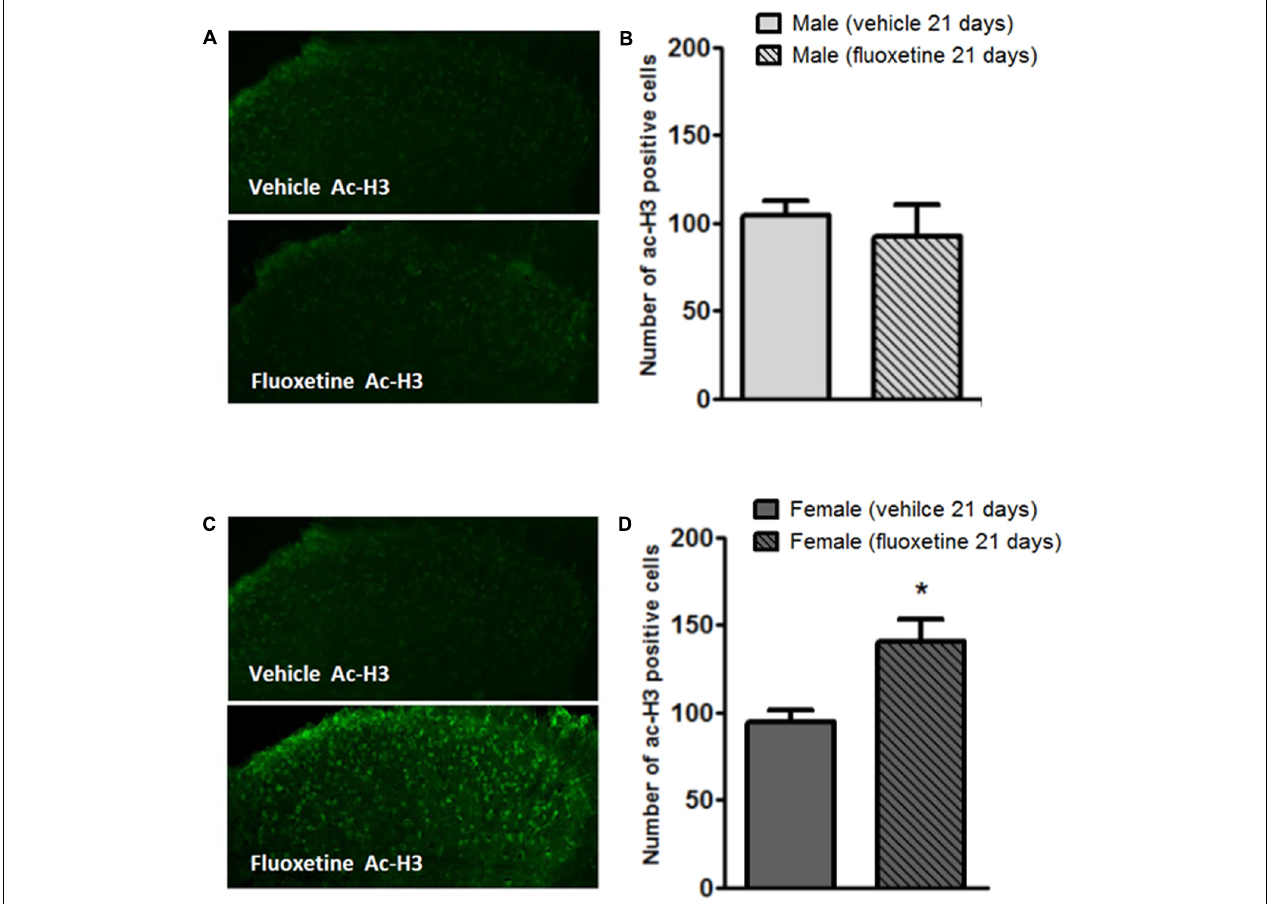
FIGURE 4 | Modulation of acetyl-H3 positive cell density in the dorsal horn of male and female mice by chronic treatment with fluoxetine. (A,C) Representative examples of acetyl-H3 immunopositive cells in the mouse dorsal horn from male and female mice treated with vehicle or fluoxetine (10 mg/kg, i.p.) for 21 days. (B,D) Quantification of immunopositive cells. Bars represent average ± SEM of three animals. ∗ p < 0.01 (Student’s t -test) versus values obtained in animals of the same sex treated with